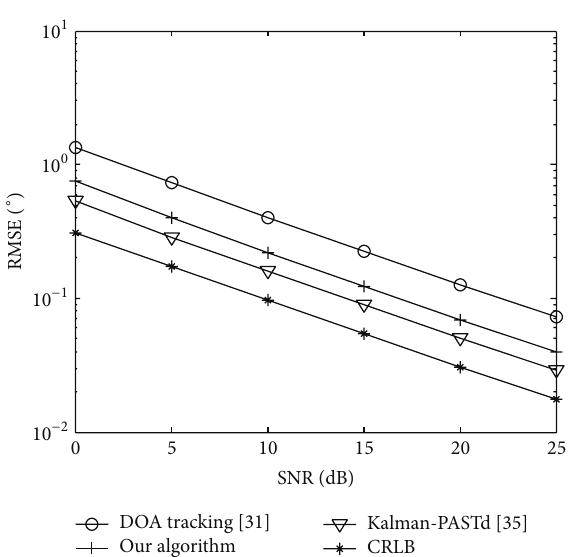
Figure 8: DOA tracking with different values of 𝑀